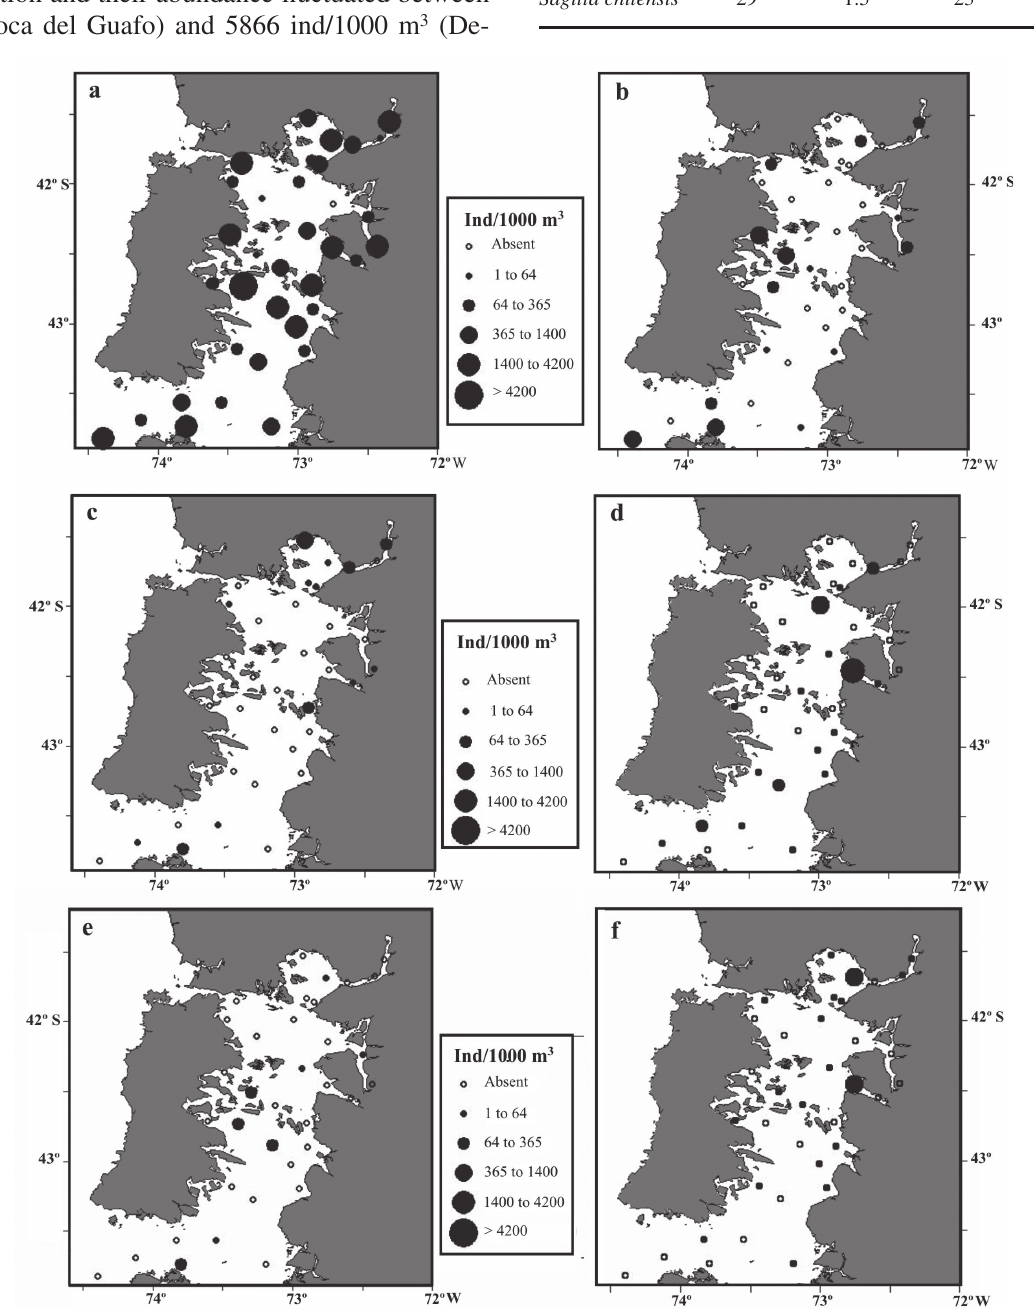
Fig . 4. – Geographic distribution of a) Sagitta tasmanica , b) Eukrohnia hamata , c) S. decipiens, d) S. enflata , e) S. chilensis , and f) S. minima